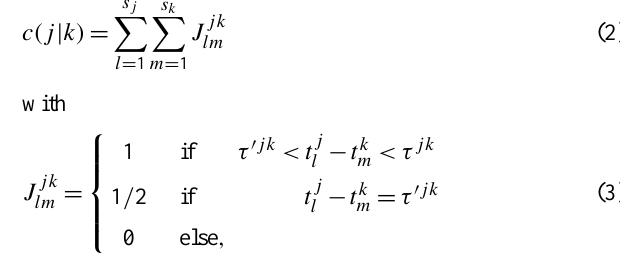
Fig. 3: Variance of the mean seasonal rainfall at each grid point. The colour scale is relative hence each grid point could be compared with the any other grid point (data used